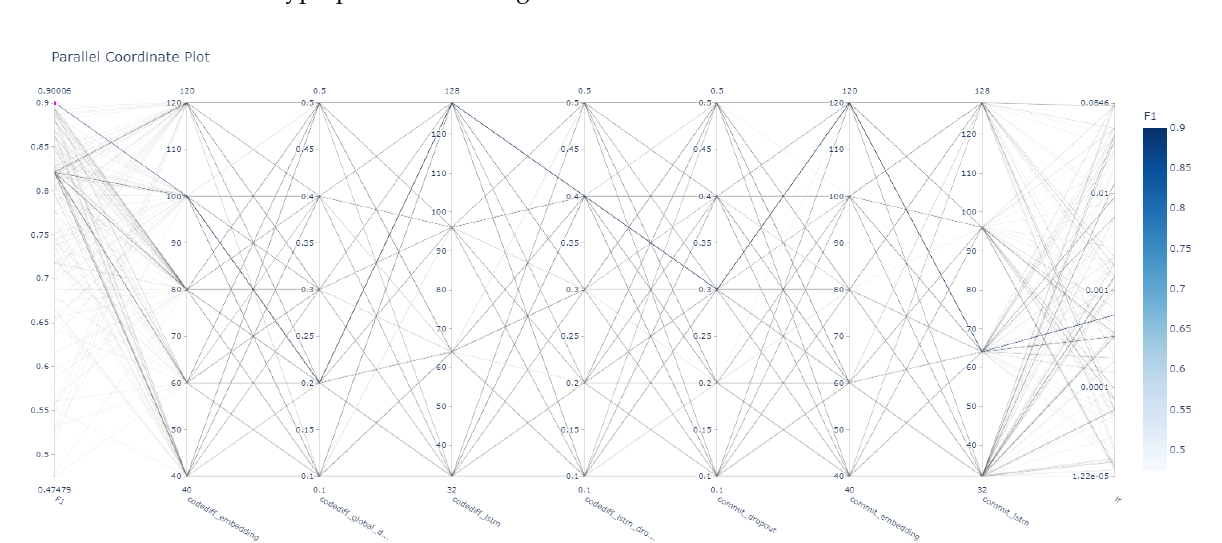
Figure 5. The parallel coordinate graph based on the F1 evaluation metric to highlight the relationship between hyperparameters in the search space.